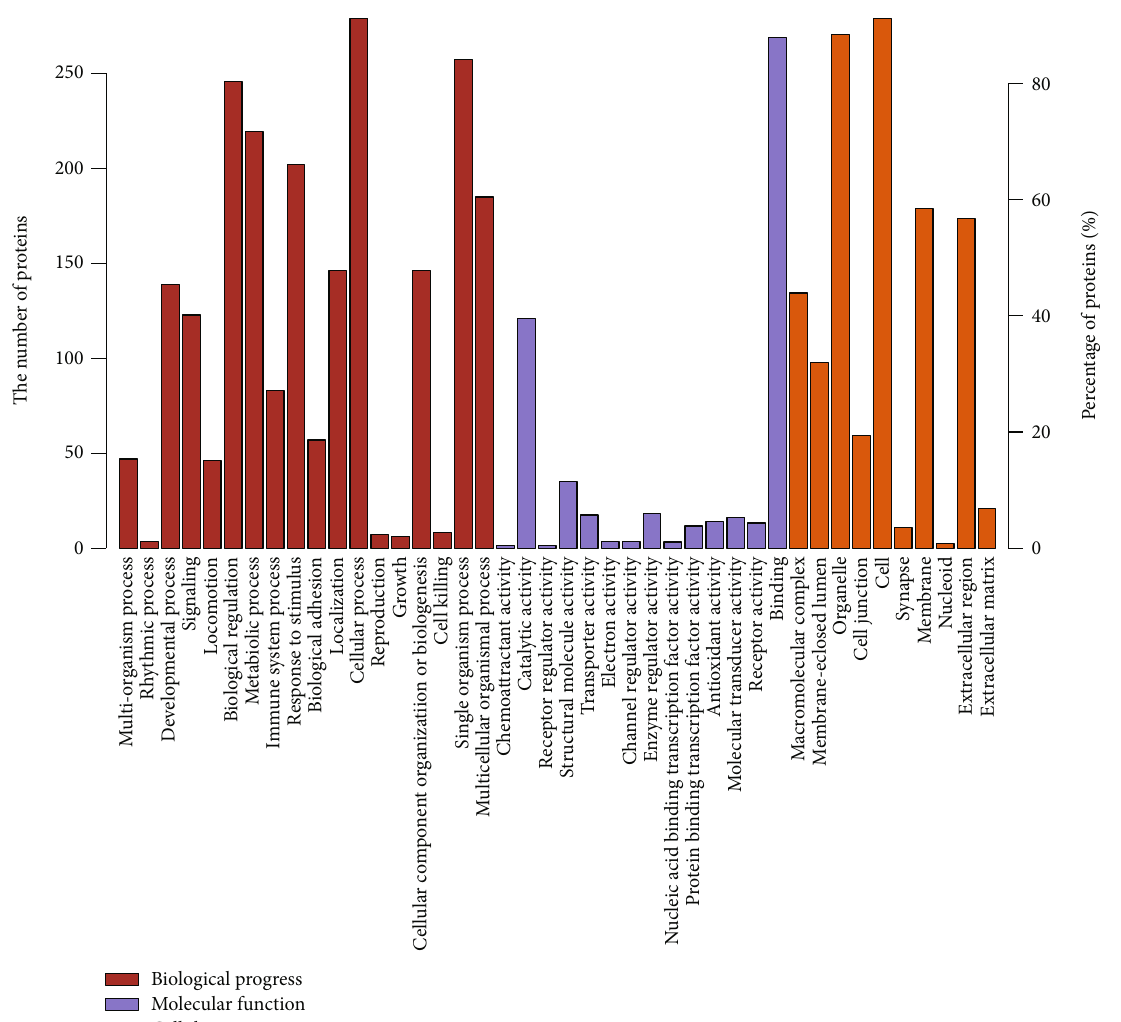
Figure 2: GO analysis of the di ff erentially expressed genes. The di ff erentially expressed proteins were enriched in molecular function (MF), biological process (BP), and cellular component (CC)